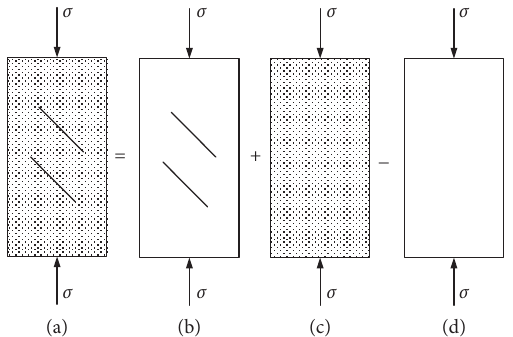
Figure 1: Schematic diagram of calculated equivalence